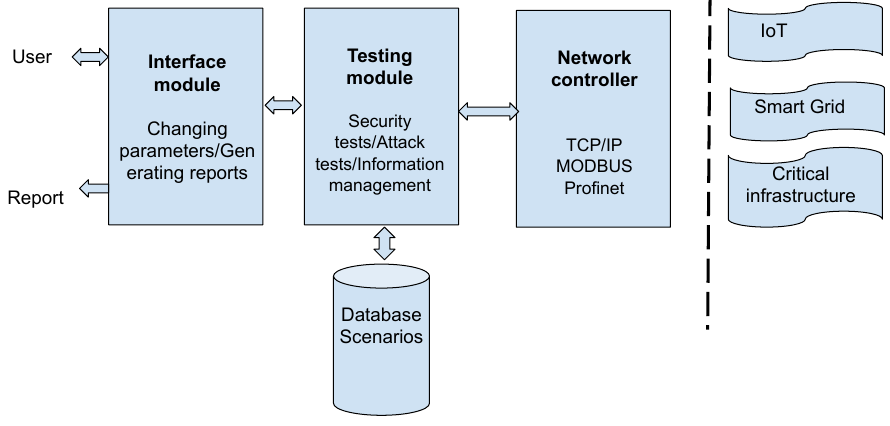
Figure 9. Architectural Design of a Test-Bed.